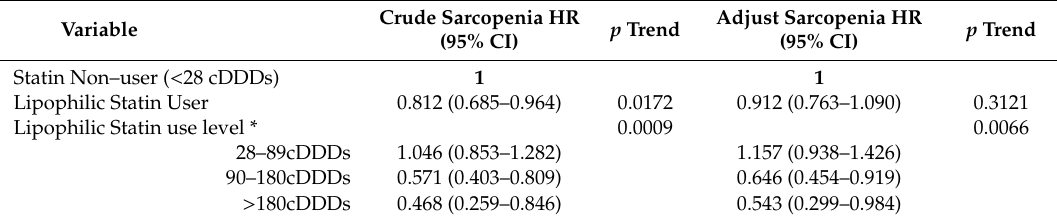
Table 6. Association between lipophilic of statins and first-time sarcopenia among CKD patients in Taiwan.